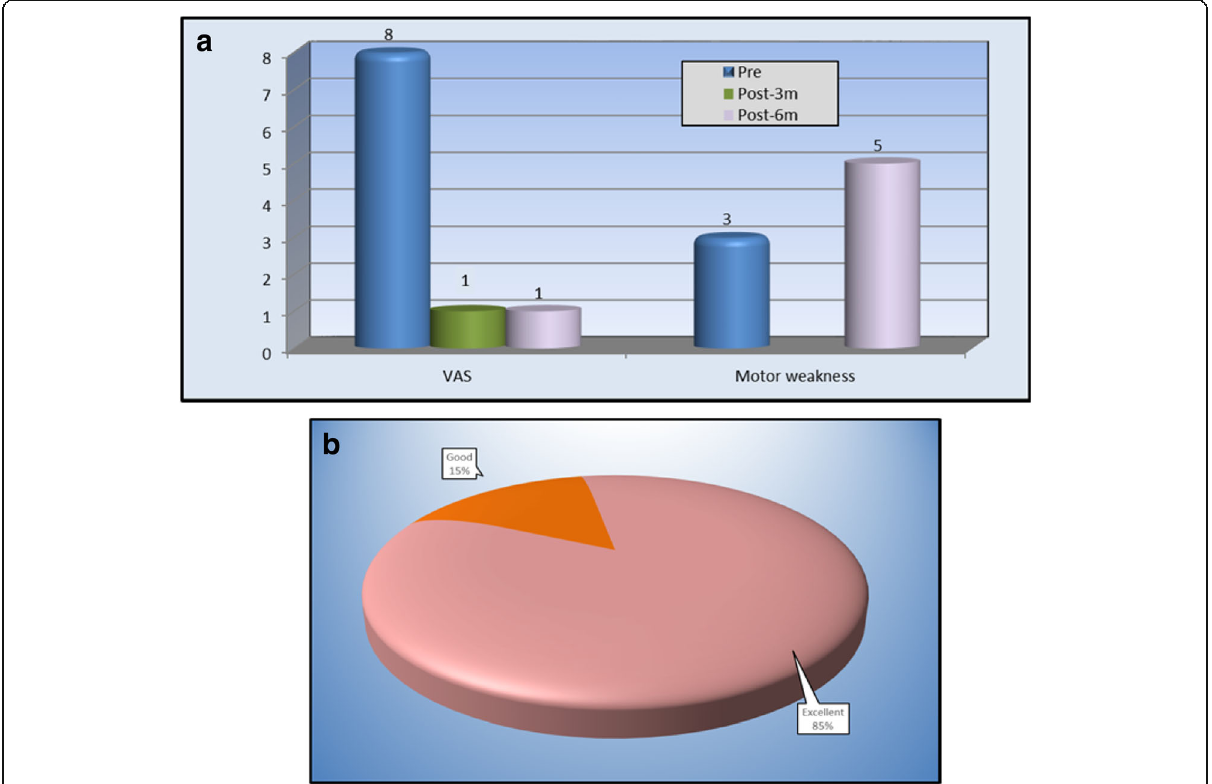
Fig. 3 a Clinical outcome based on visual Analog score (VAS) for leg pain. b Functional outcome by